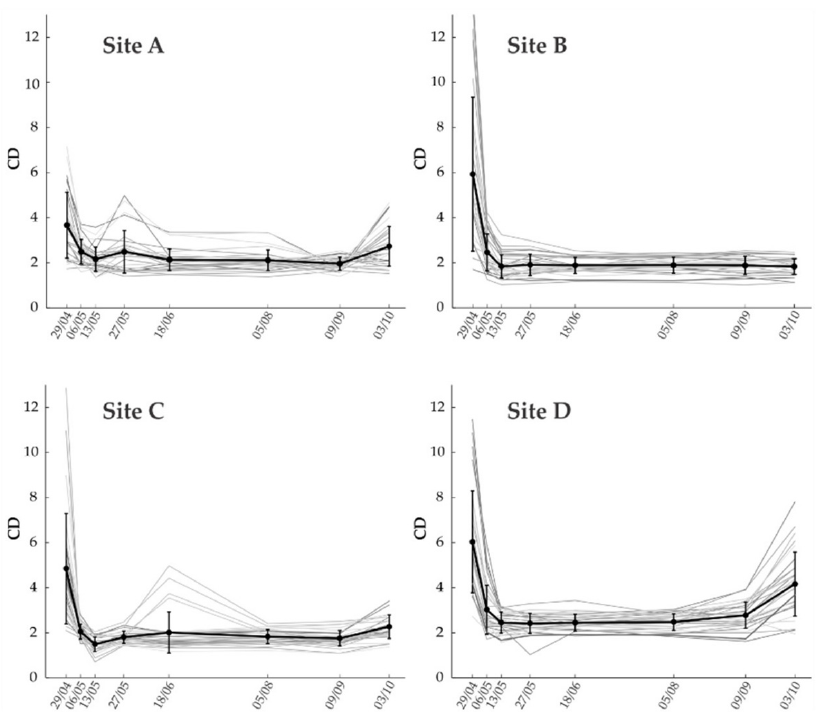
Figure 5. Evolution of CD values over time in Site A, B, C and D, with the dates of measurements presented on the X-axis (in 2019). Every grey curve shows the evolution of individual measurement locations, whereas the dark black line shows the average values from one site with the error